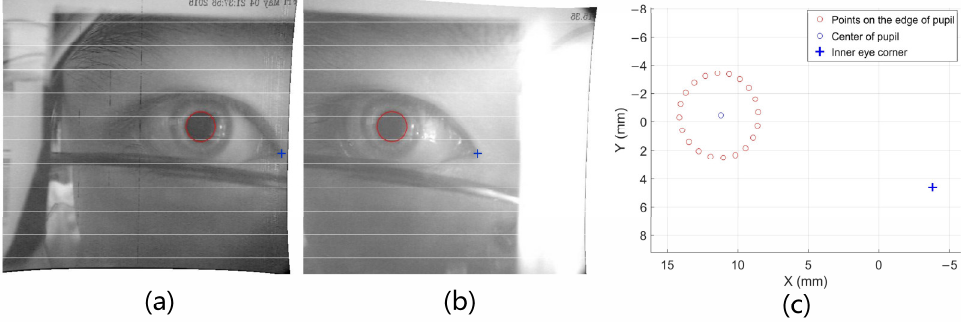
Figure 5. ( a , b ) show the images captured by a pair of eye cameras after epipolar rectification, and the extracted pupil contour and inner eye corner are marked in these two graphs; and ( c ) represents the spatial coordinates of detected eye features.